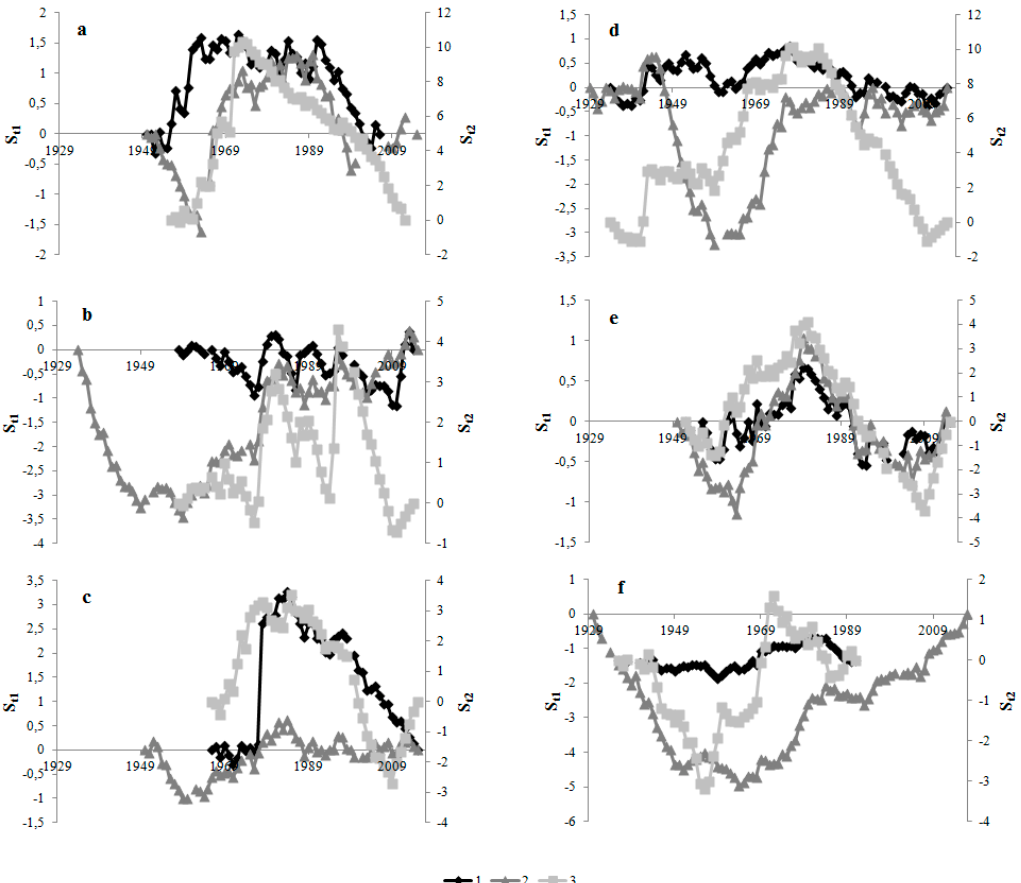
Figure 4. Trends in water discharge (1, S t 1 ), precipitation (2, S t 1 ) and suspended sediment yield (3, S t 2 ) variability in the Penzhina River (Kamenskoe gauge, ( a )), the Khairyuzova River (Khairyuzovo gauge, ( b )), the Udova River (Rus’ gauge, ( c )), the Avacha River (Elizovo gauge, ( d )), the Kirganick River (Kirganick gauge, ( e )), the Kamchatka River (Bol’shie Sheki gauge, ( f